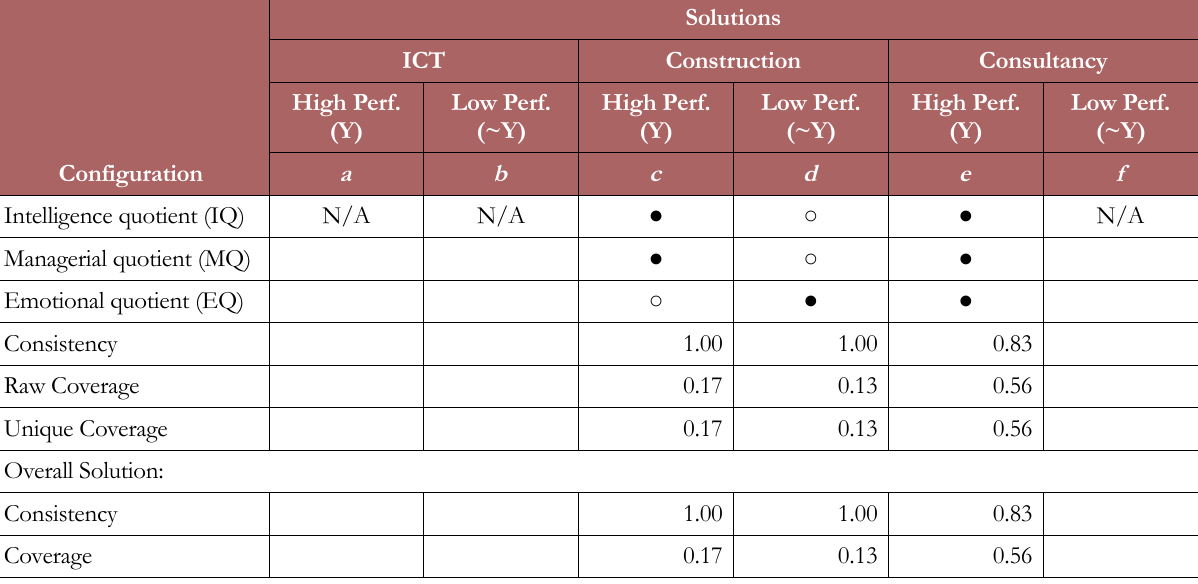
Table 10. The Leadership Configuration Table across Three Industry